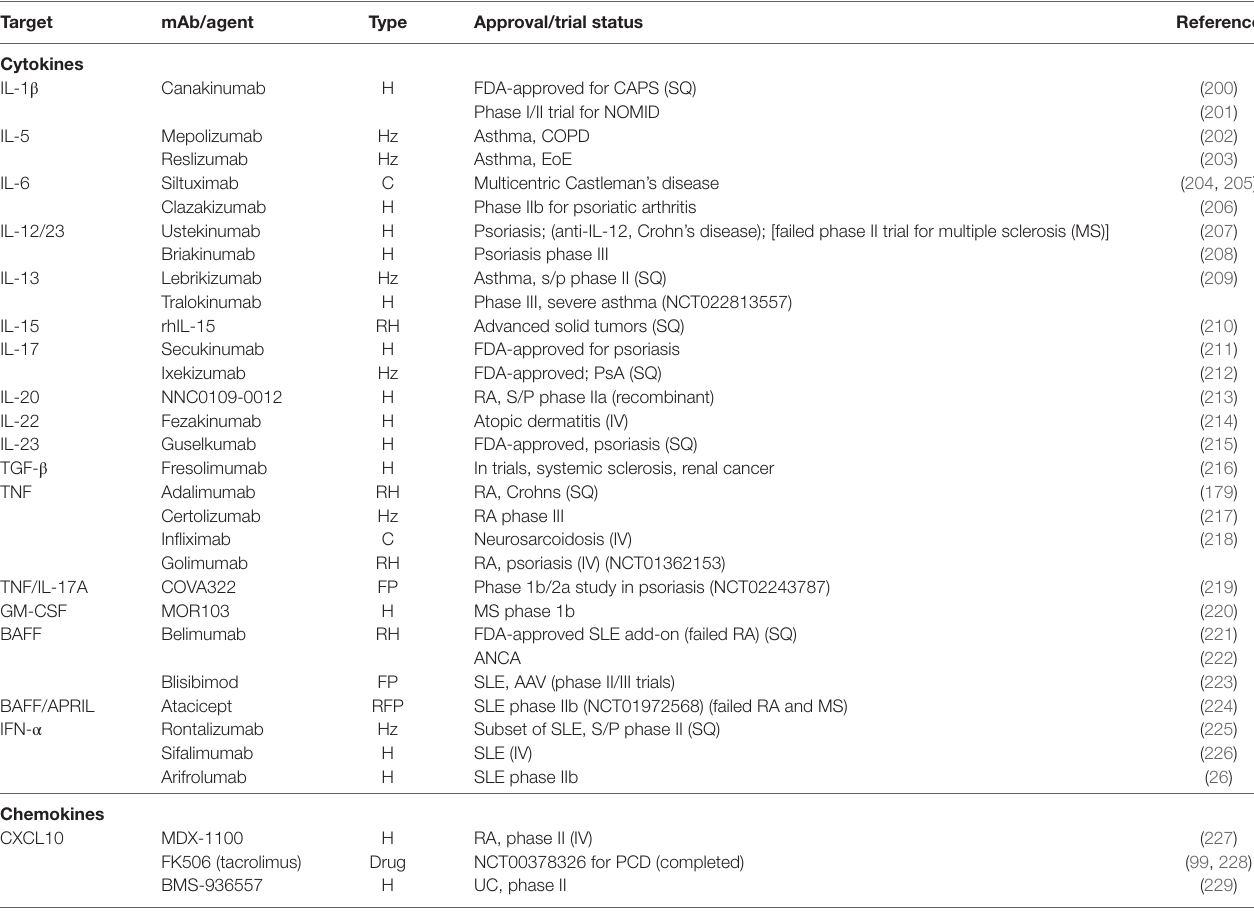
TABle 8 | Overview of some clinical trials/approvals for targeting chemo/cytokines.